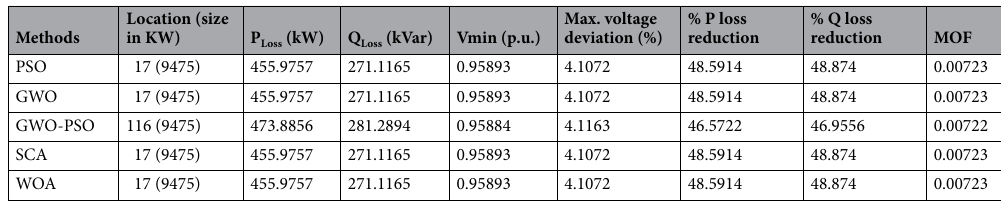
Table 3. Performance measurement after 1-DG integration with different algorithms.